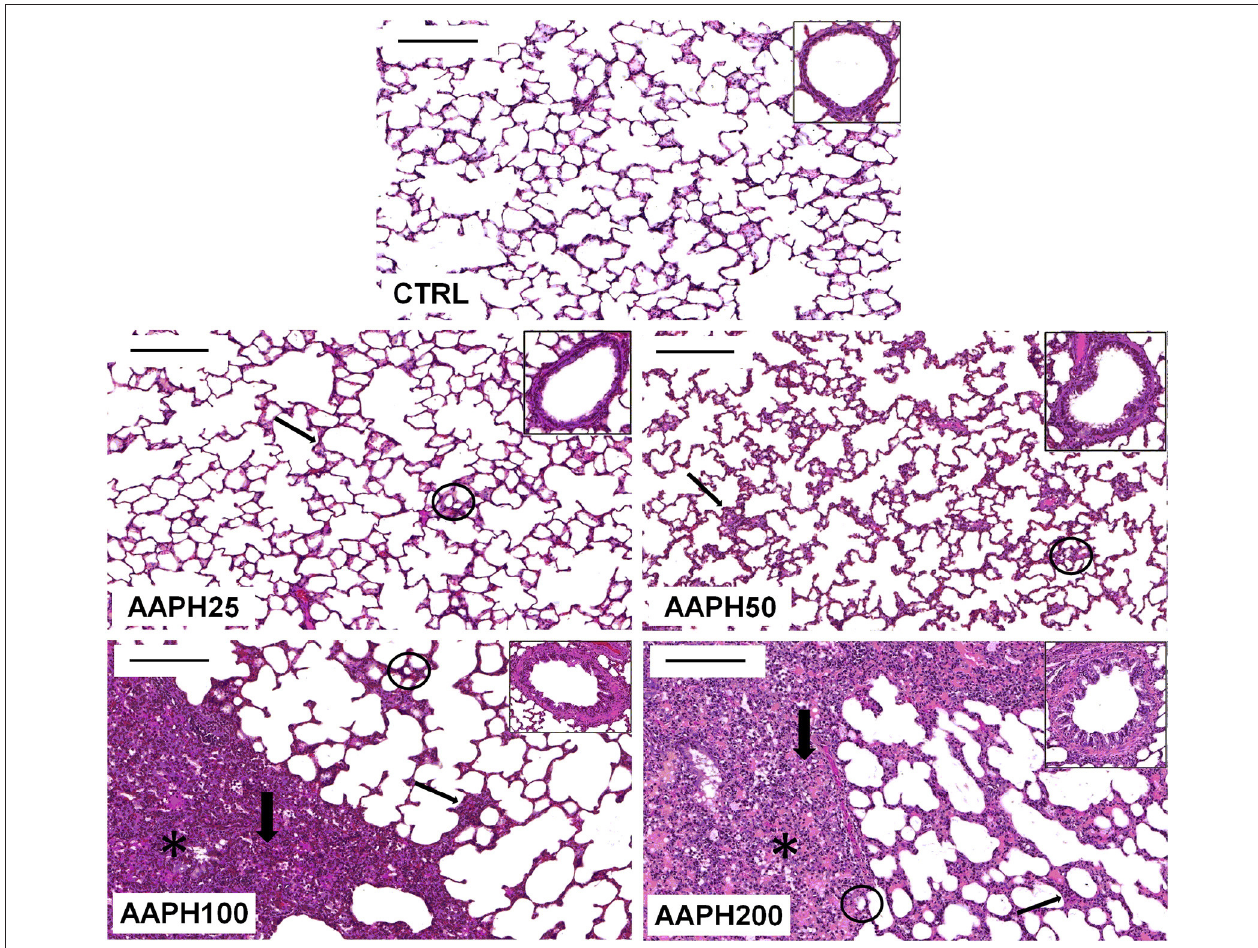
FIGURE 2 | Photomicrographs of lung parenchyma stained with hematoxylin–eosin. Measurements were done 72 h after the exposure of animals to saline solution (CTRL) or different amounts of 2,2 ′ -azobis (2-amidinopropane) dihydrochloride (AAPH25, 50, 100, and 200 mg/kg in saline solution). Thin arrows: thickened septa; thick arrows: cellular infiltrate; circles: alveolar collapse; and *: hepatized area. Inserts show representative airways in each group. Bars